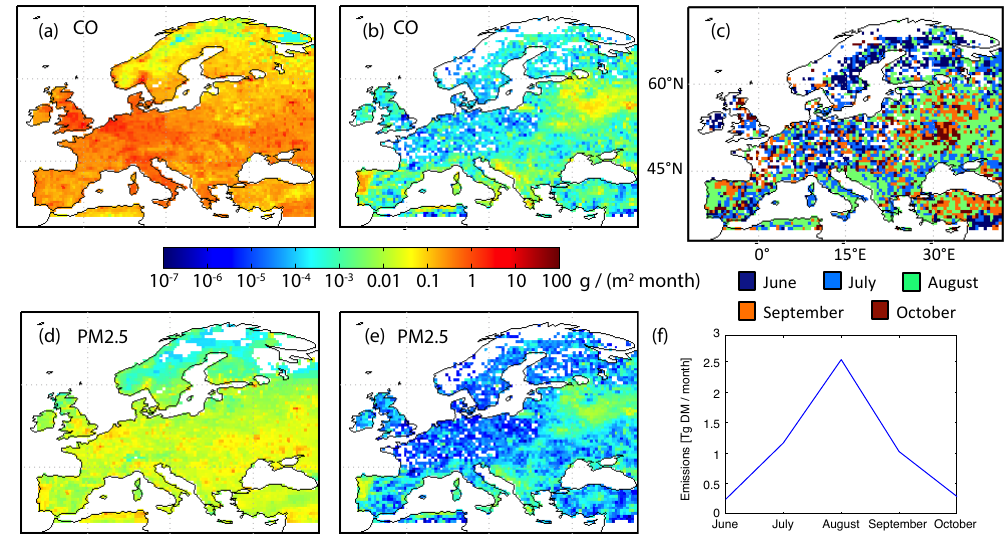
Figure 2. Emissions of CO (a, b) and PM 2 . 5 (d, e) from anthropogenic sources (a, d) and wildfires (b, e) during peak month of fire season (c) . Total wildfire emissions climatology 1997–2014 (f) in dry mass per month during the fire season for the European study. White: zero emissions.